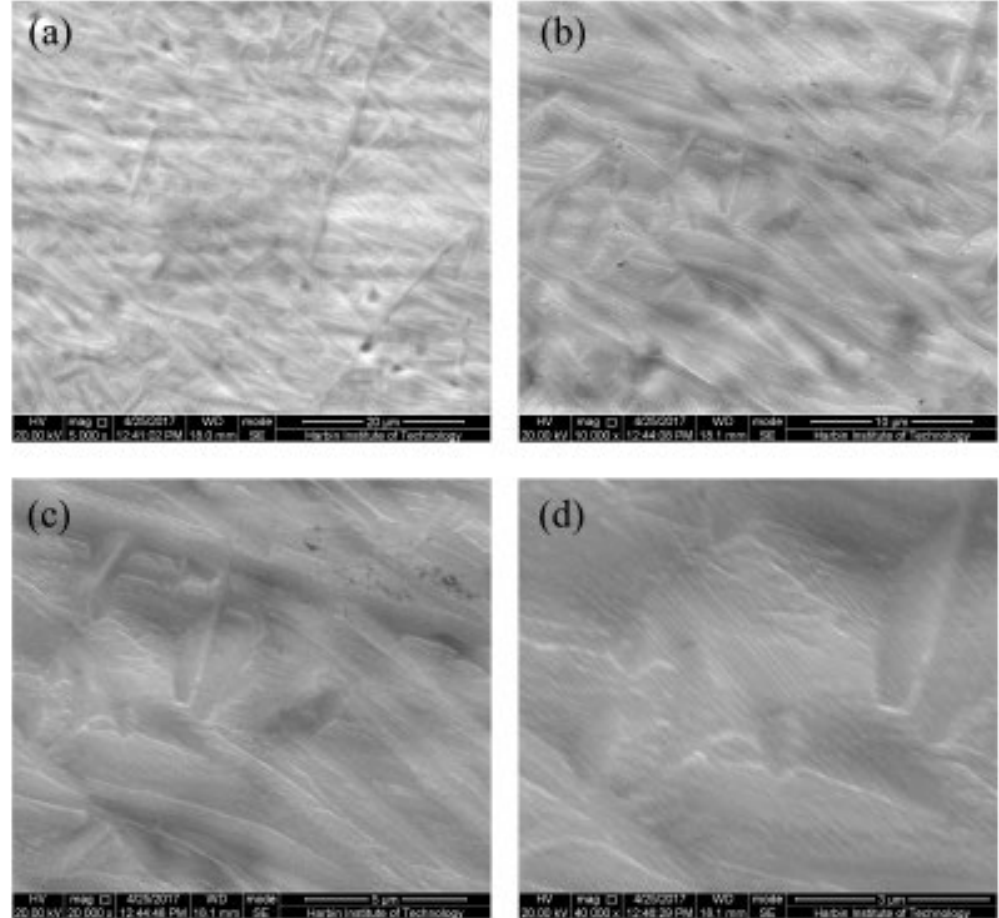
Figure 6. Typical morphology of surface of damaged titanium alloy sheet after electropulsing. ( a – d ) are Magnified 5,000, 10,000, 20,000 and 40,000 times SEM image,